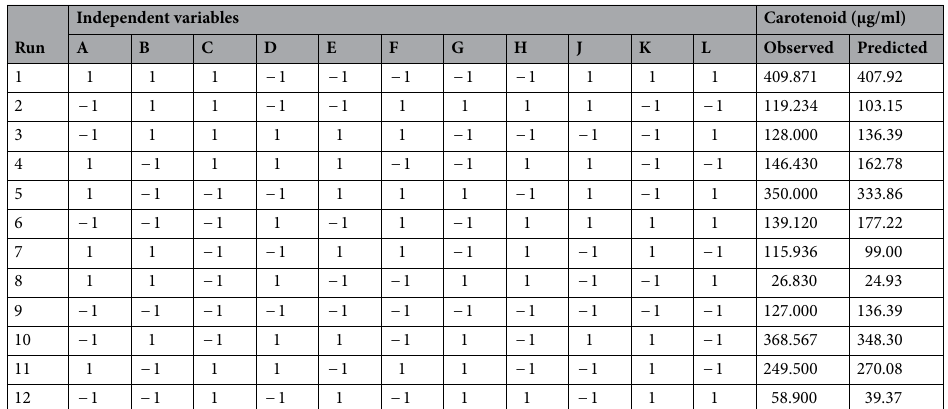
Table 1. Plackett–Burman design for screening the significant independent variables affecting carotenoids production by Kocuria sp. RAM1. A: Peptone (g/l), B: Yeast extract (g/l), C: Beef extract (g/l), D: NaCl (g/l), E: Glucose (g/l), F: MgSO 4 (g/l), G: pH, H: Temperature, J: Agitation (rpm), K: Inoculum size (%), L: Incubation period